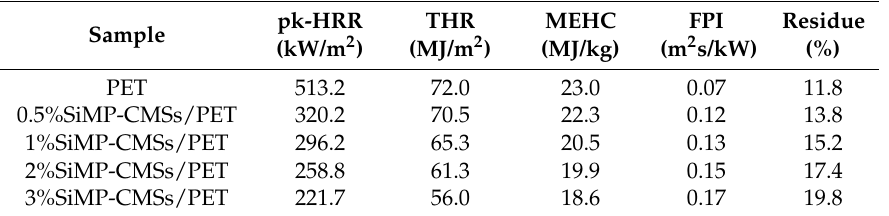
Figure 6. Heat release rate (HRR) ( a ) and total heat release (THR) ( b ) curves of SiMP-CMSs/ Poly(ethylene terephthalate (PET) composites. Table 2. Main heat parameters of SiMP-CMSs/PET composites. MEHC, mean effective heat of combustion; FPI, fire performance index.